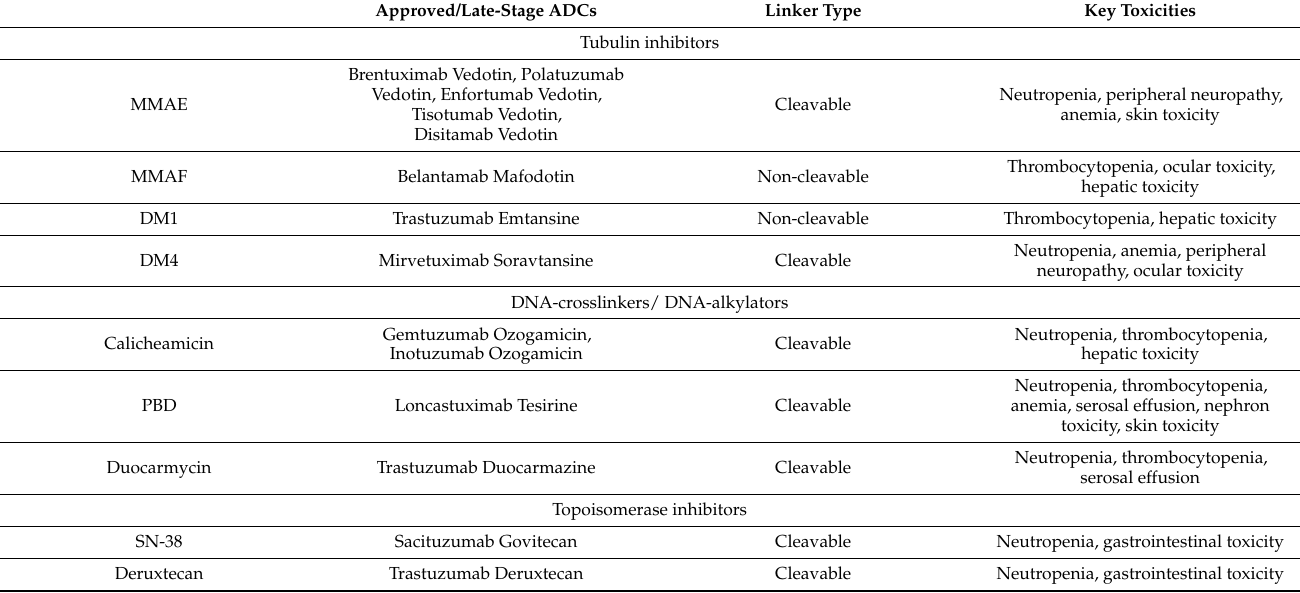
Table 2. Frequently reported dose-limiting toxicities associated with payload